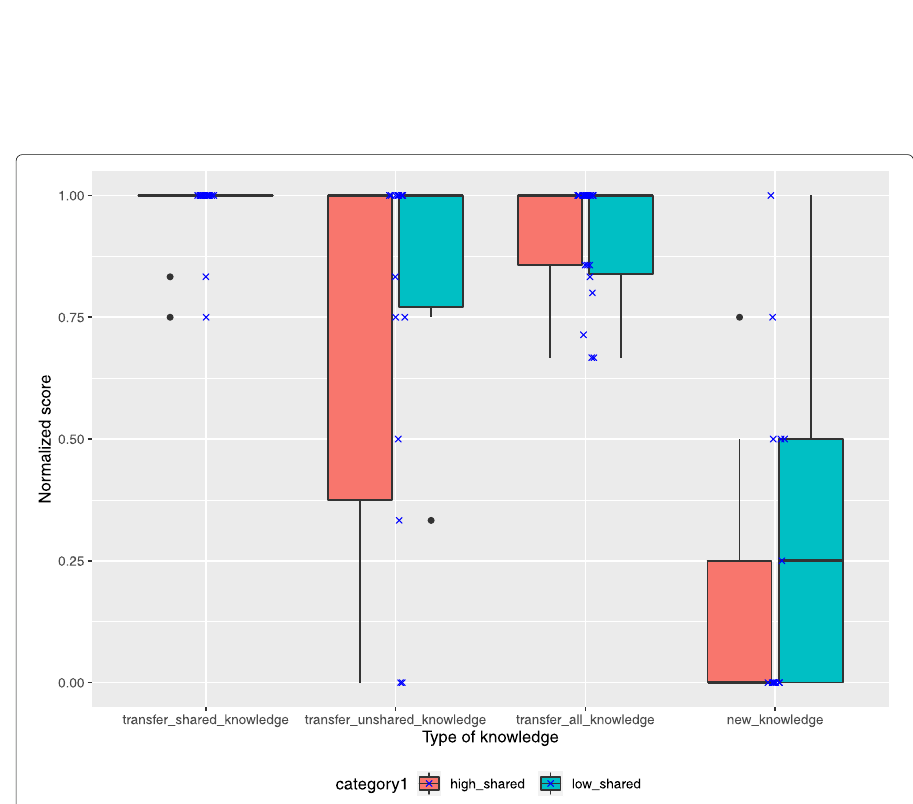
Fig. 6 Distribution of knowledge transfer and new knowledge in high- and low-shared-knowledge groups ( n = 10 and n = 11,